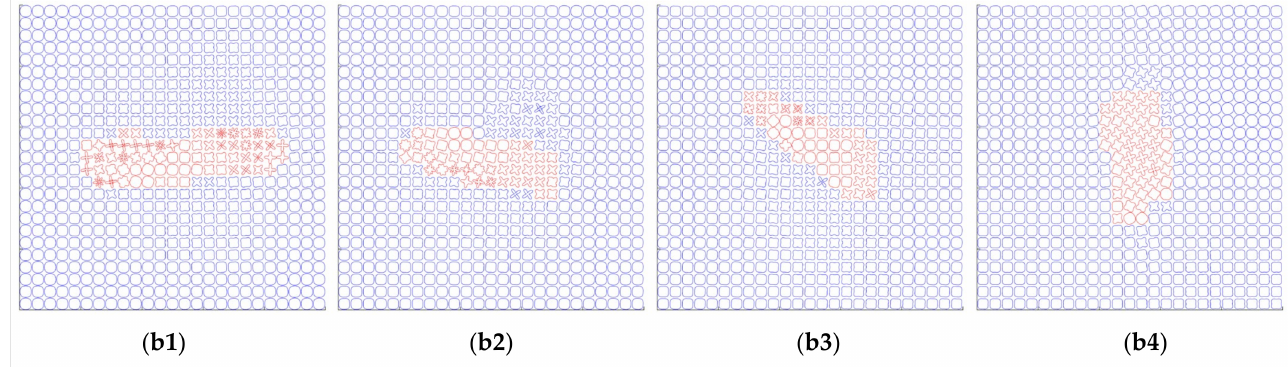
Figure 3. The polarimetric coherence patterns | γ HH-VV ( θ ) | of ship slices from ( a1–a4 ) Radarsat-2 PolSAR dataset, ( b1–b4 ) GF-3 PolSAR